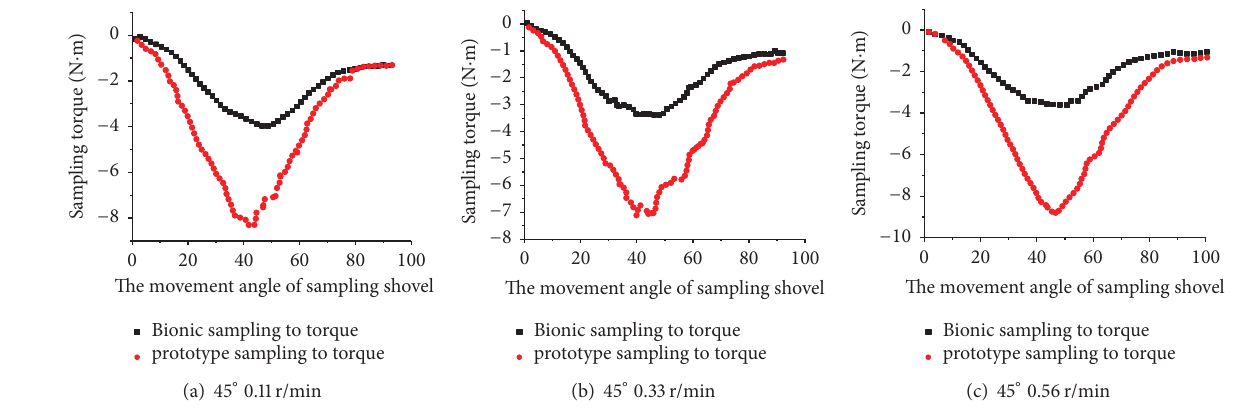
length of the second toe is 12.72 mm, the thickness is 2.51 mm, and the height is 4.0 mm, which are bigger values than those for the rest of the toes. The fourth